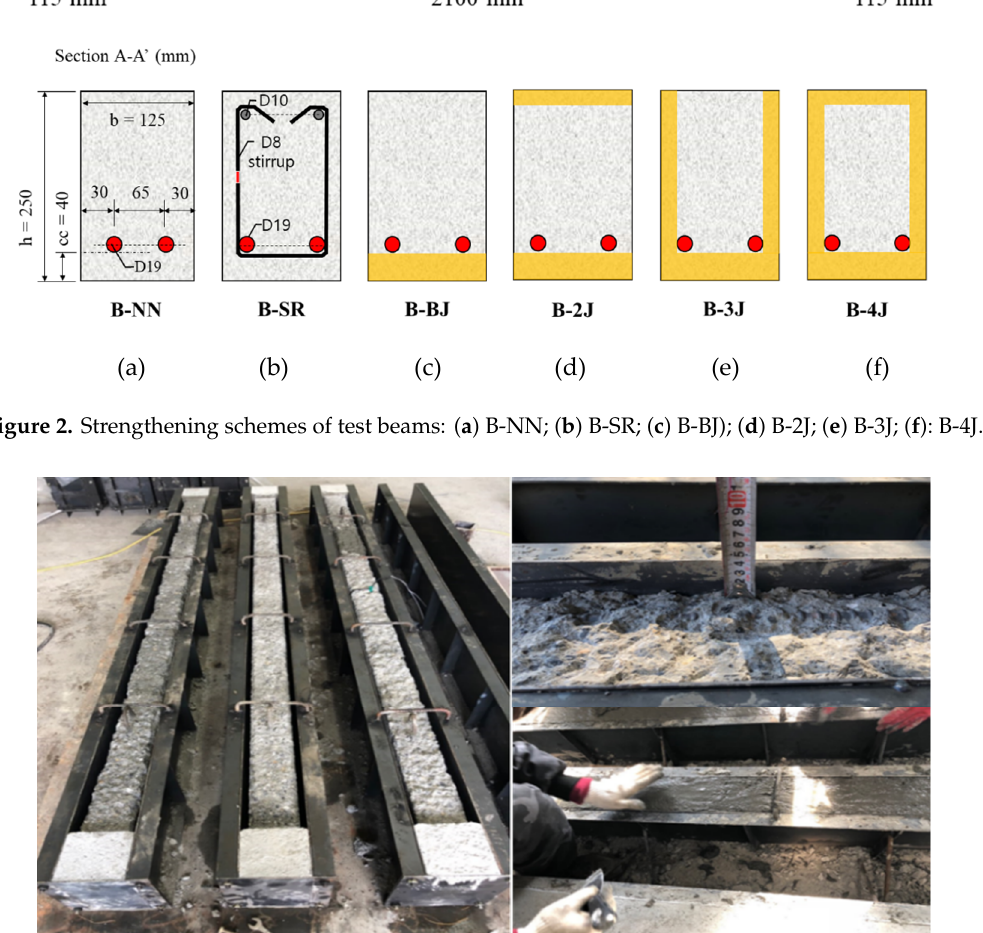
Figure 3. Strengthening process using chiseling and NSHSDC cast in situ strengthening technique.